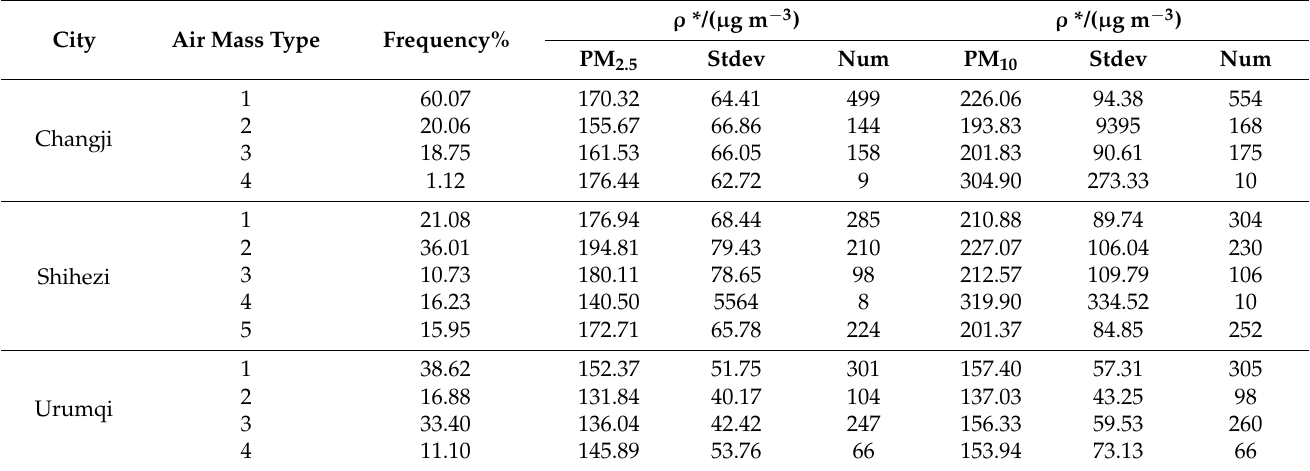
Table 3. Statistical results of the mass concentration of all kinds of airflow in the four seasons of the Wu-Chang-Shi